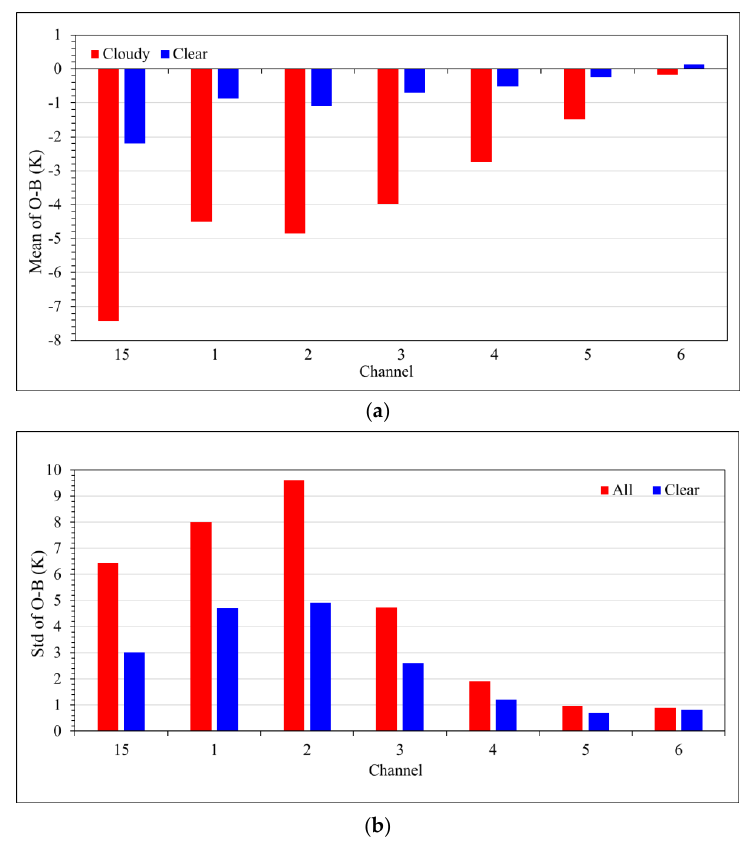
Figure 11. Histograms of the ( a ) average O − B of observations under cloudy (red) and clear sky (blue), and ( b ) O − B standard deviations of observations under all-sky (red) and clear-sky (blue) conditions over East Asian land areas from June to August 2019.